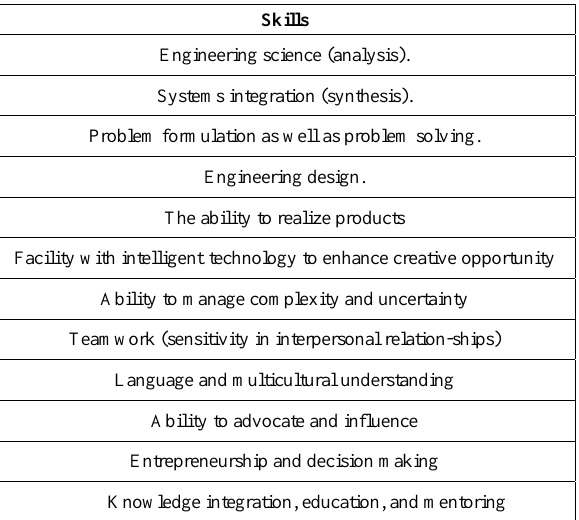
TABLE II. T HE SKILLS SUGGESTED BY ENGINEERS [7]